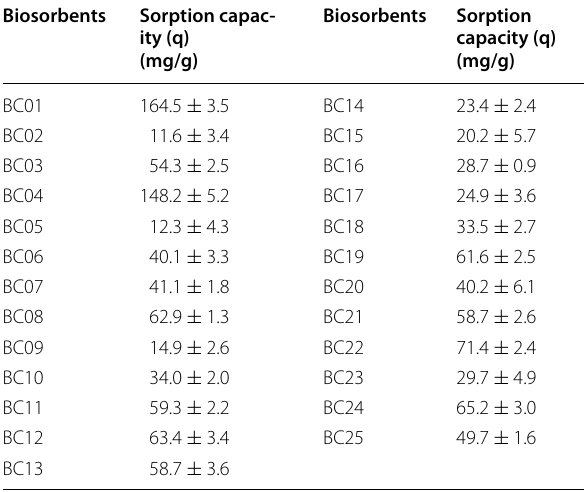
Table 1 Screening studies for Pb(II) biosorption Biosorbents